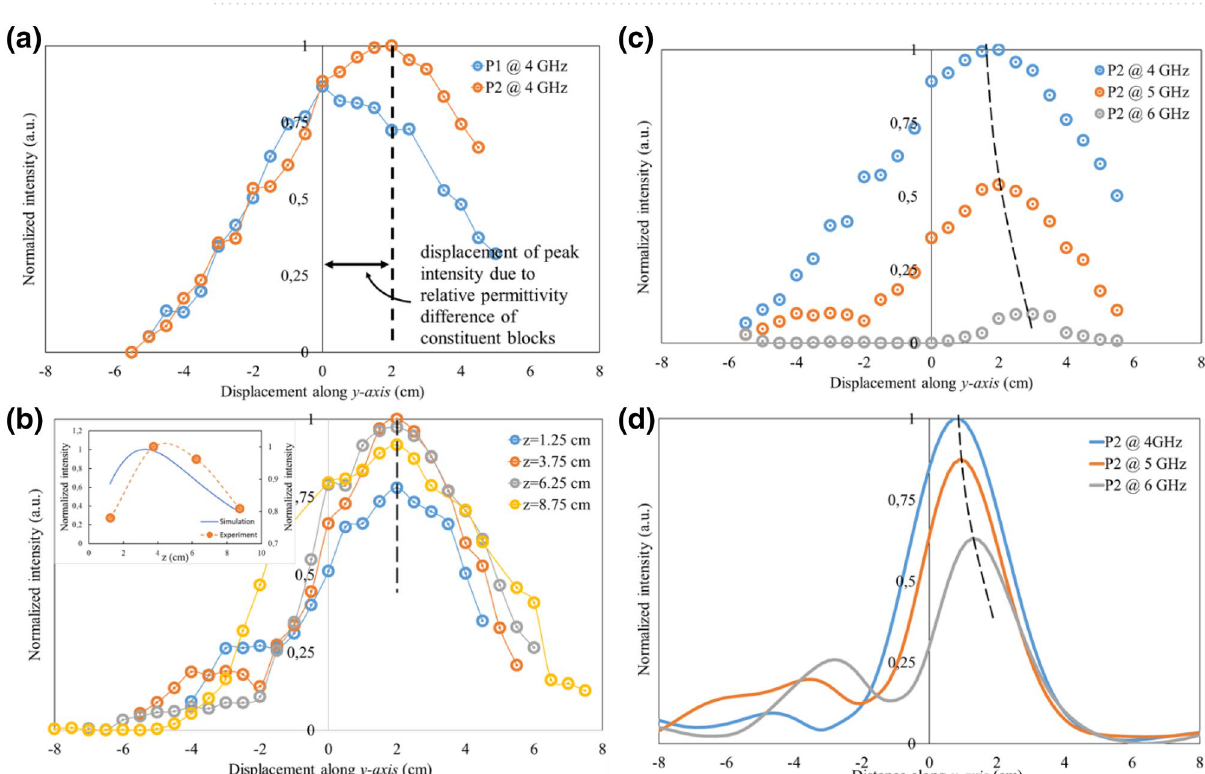
Figure 4. Experimental NF electric field intensity measurements ( a ) along y-axis for prototypes P1 and P2 at a fixed separation distance of z = 3.75 cm from the sensor for illumination frequencies of 4 GHz, ( b ) along y-axis for just prototype P2 at 5 GHz for different separation distances, z (inset: EM field intensity variation along z-axis measured experimentally (orange curve) and numerically (blue curve) at y = 2 cm. (c, d) Comparison of NF intensities for P2 at illumination frequencies of 4, 5 and 6 GHz for experiments (c) and simulations